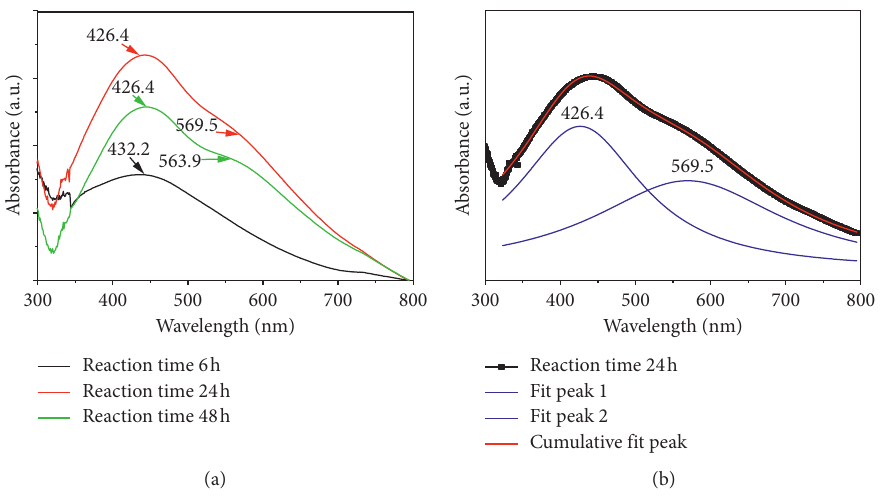
Figure 2: The UV-Vis spectra of samples at different reaction